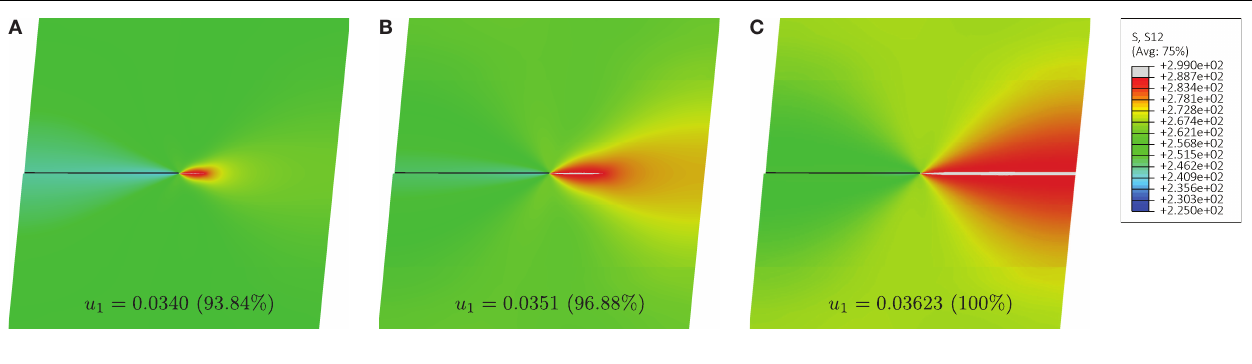
FIGURE 7 | Contour plots of the shear stress σ 12 for the case of material close to shear band instability ( E p = 300MPa) .The gray region corresponds to the material at yielding σ 12 ≥ 500 / different stages of deformation are shown, corresponding to a